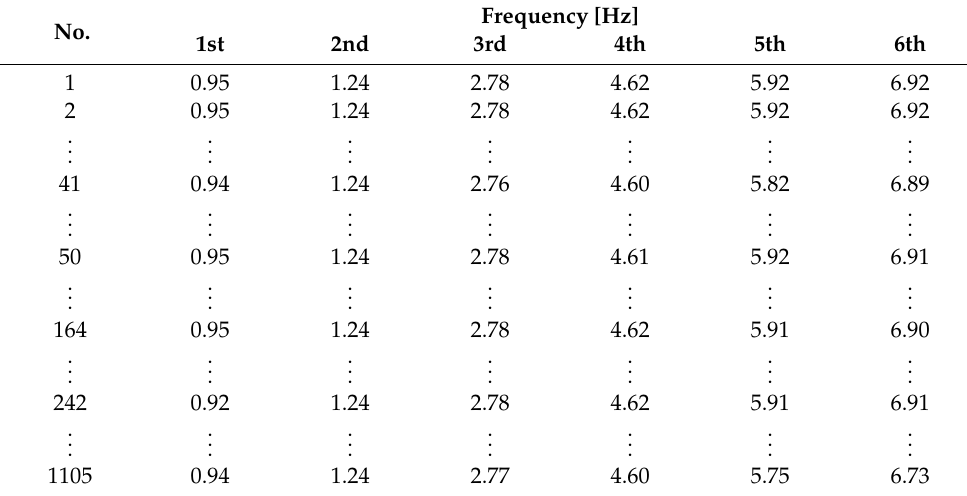
Table 3. Debonding damage map.